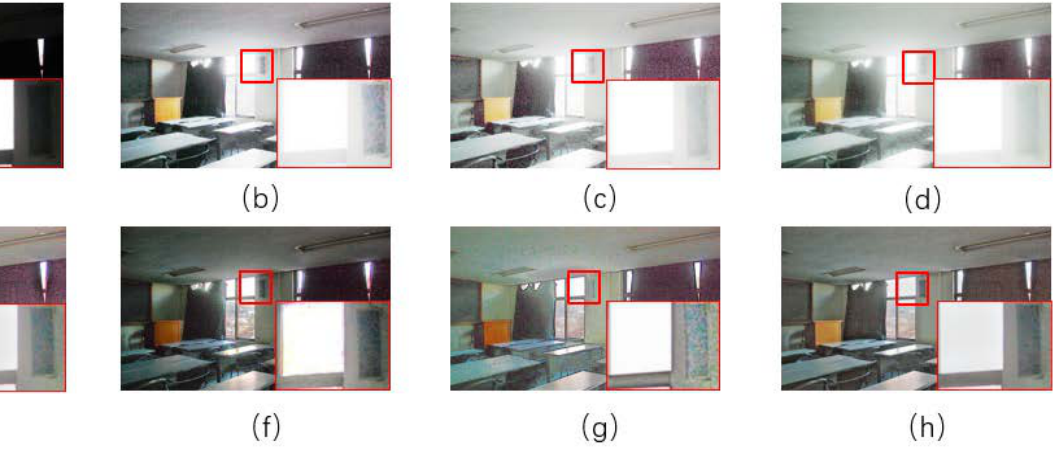
Figure 3. Contrast of indoor image enhancement effect. ( a ) Original image; ( b ) HE; ( c ) Retinex; ( d ) MSR; ( e ) MSRCP; ( f ) LIME; ( g ) RetinexNet; ( h ) Ours. ( d ) MSR; ( e ) MSRCP; ( f ) LIME; ( g ) RetinexNet; ( h )